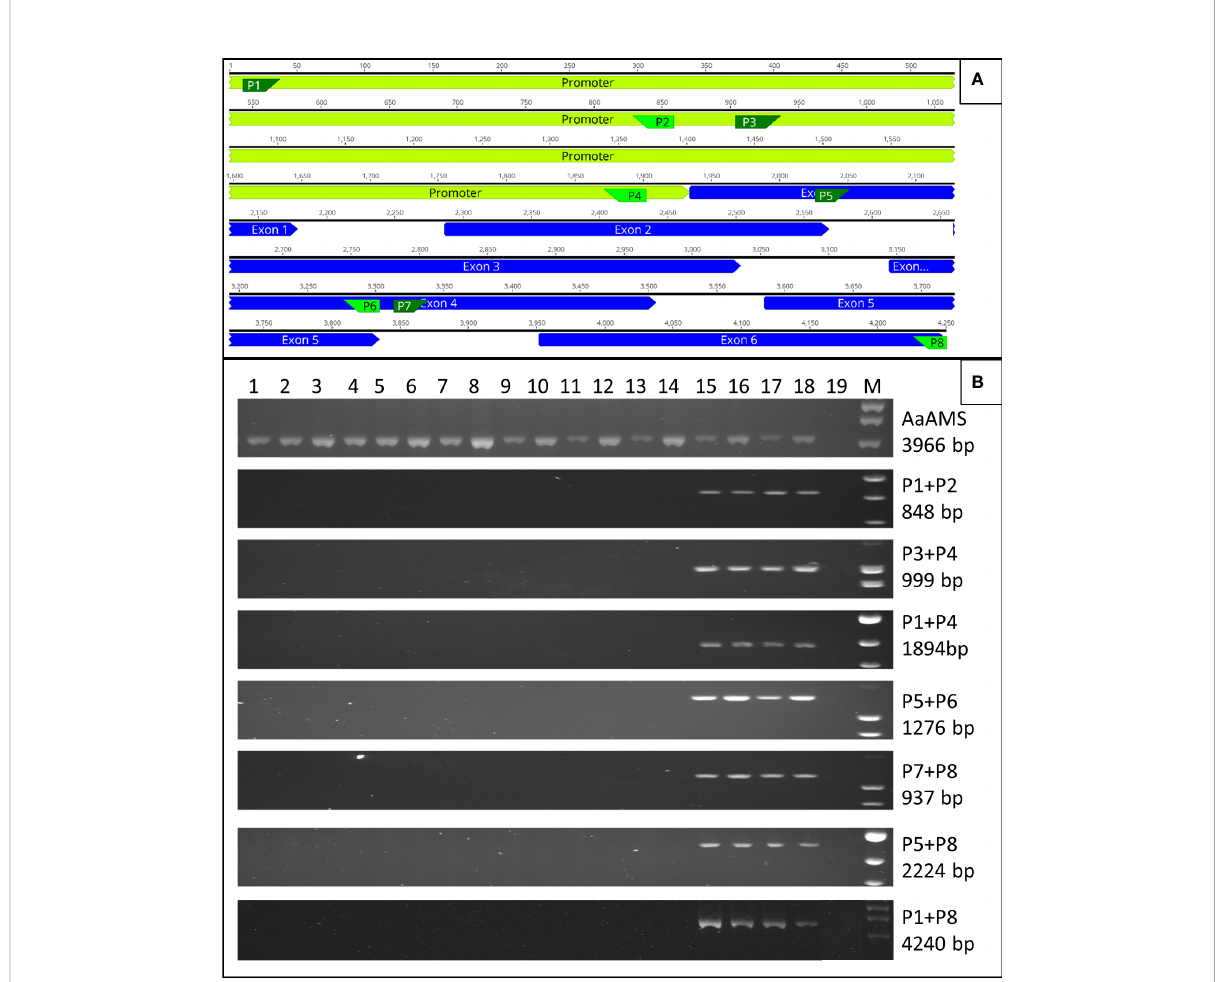
FIGURE 5 Genomic deletion in camphor-0 lines. (A) Location of primers (P1-P8) designed for various parts of AaBPS gene including5 ’ promoter region (Primer sequences in Table S3). (B) PCR ampli fi cation on genomic DNA isolated from 14 camphor-0 M2 (lines 1-14), two individual Artemis F1 (lines 15-16), Artemis Parents C4 (line 17) and C1 (line 18) using primers annotated on panel (A) Line 19 – no template control. Line M – Gene Ruler ™ 1kb DNA ladder (Thermo Fisher). Ampli fi cation of full length AaAMS gene (GenBank Accession AF327527) used as a positive control. Size of PCR amplicons predicted from genomic DNA sequence